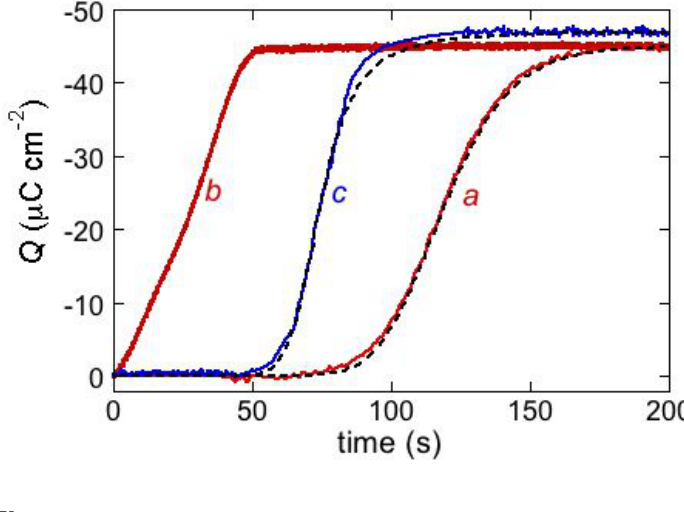
Figure 10. The red curves a and b are charge transients following potential jumps from − 0.30 V to the − 1.00 V at a DPTL/DOPC tBLM immersed in aqueous 0.1 M KCl containing 0.4 μ M distinctin. Curve a was obtained by the pristine potential jump; curve b was obtained by a second potential jump after a rest time of 30 s at − 0.30 V. The dashed curve a was calculated using the parameters θ = 0.1, n = 2, k v h,R2 = 1 × 10 − 4 s − 3 , 0 h,N k k R2 = 4 × 10 3 s − 3 , k = 7 × 10 − 3 cm 2 s − 1 and p = 0.1. The parameter θ denotes the N d ,R 0 fraction of the whole surface of the tBLM initially covered by flat clusters. The blue curve c is a charge transient following a potential jump from − 0.30 V to − 0.65 V at a DPTL/DOPC tBLM immersed in aqueous 0.1 M KCl containing 0.4 μ M alamethicin. The corresponding dashed curve was calculated using the parameters θ = 0.4, n = 0